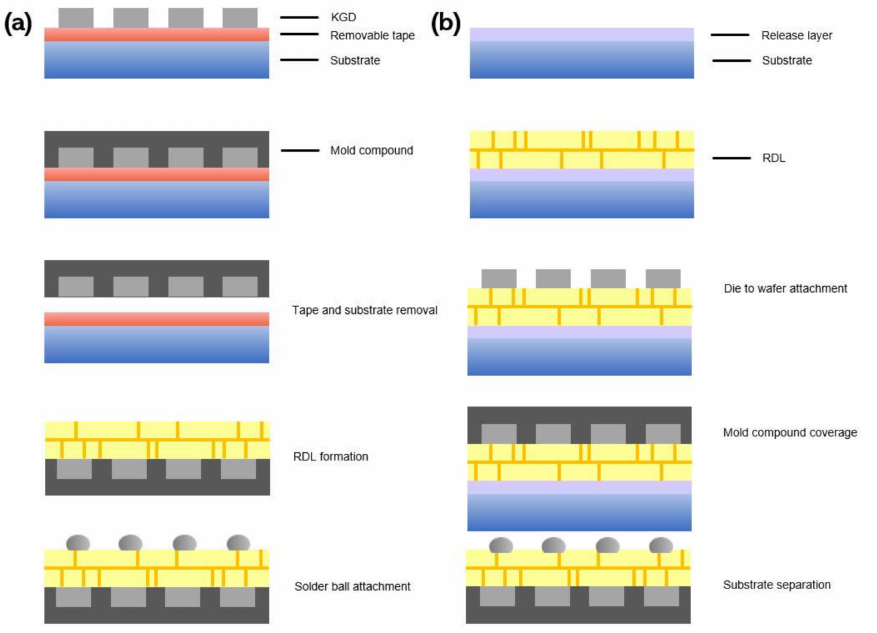
Figure 3. Two typical RDL processes in FOWLP: chip-first process flows; ( a ) chip-last process flows ( b